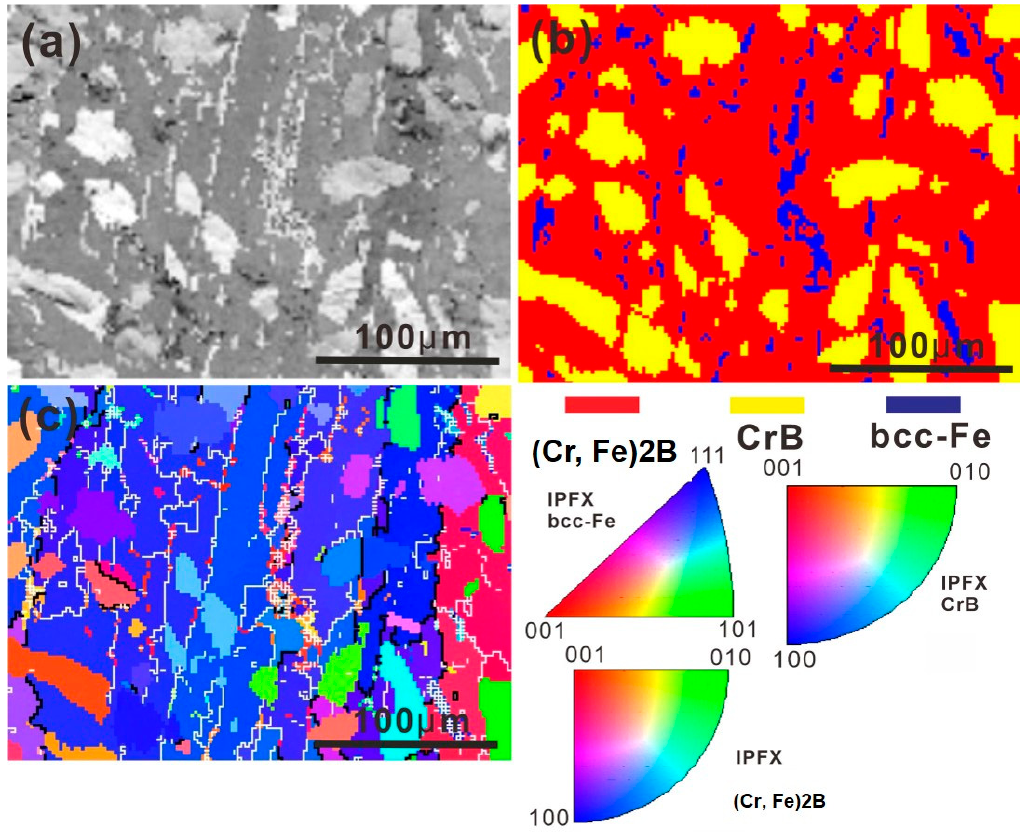
Figure 3. Electron backscattered diffraction (EBSD) analysis of the as-cast microstructure in the Fe-Cr-B alloy: ( a ) the band contrast map; ( b ) phase distribution map; and ( c ) the inverse pole figure (IPF) map.